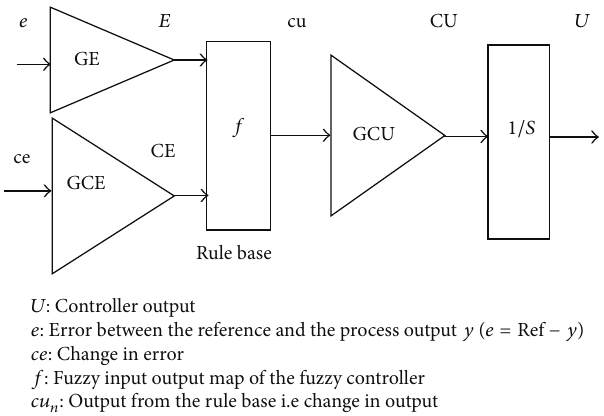
Figure 4: Block diagram of incremental fuzzy